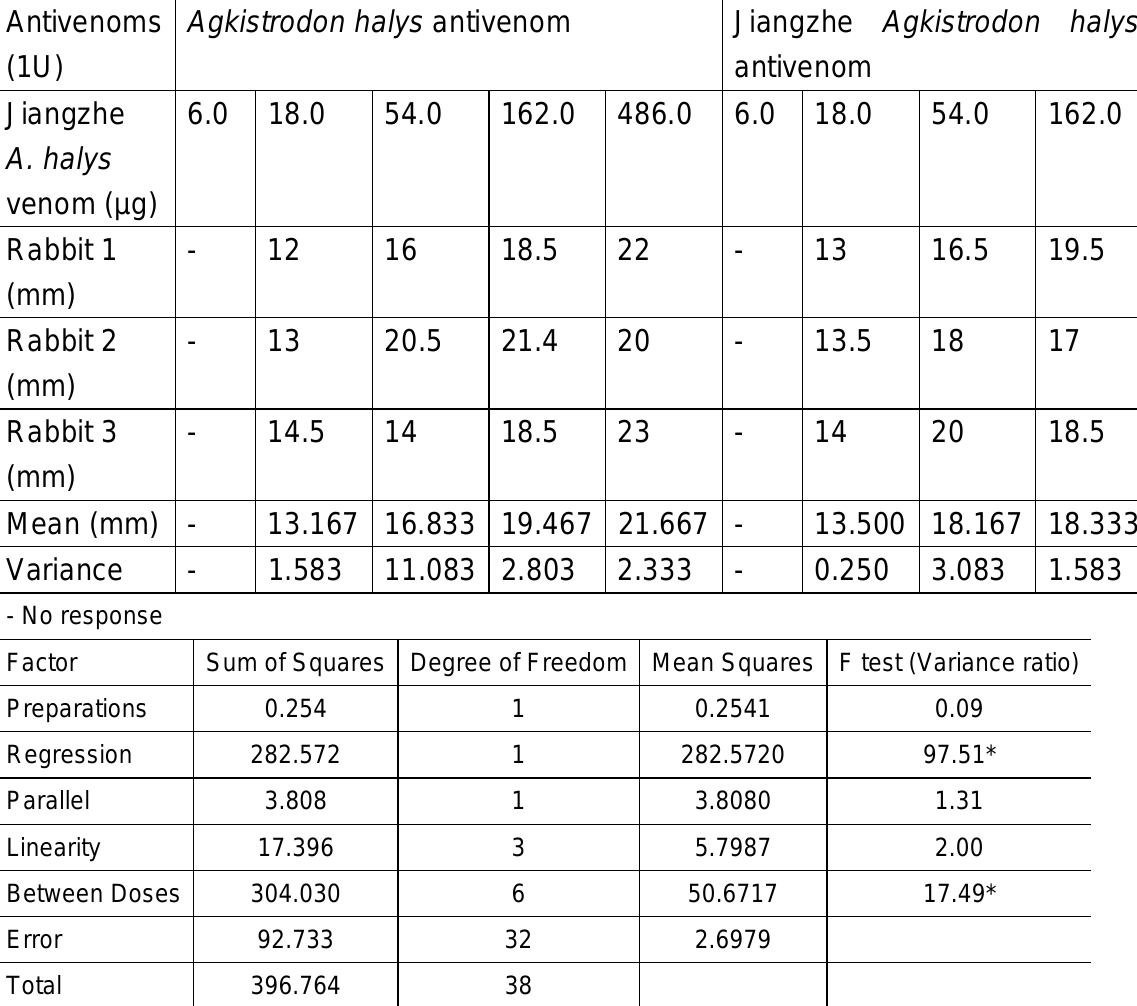
Table 4: Measurements of the neutralization of Jiangzhe Agkistrodon halys venom by one unit of antihemorrhagic activity (1U) of Agkistrodon halys and Jiangzhe Agkistrodon halys